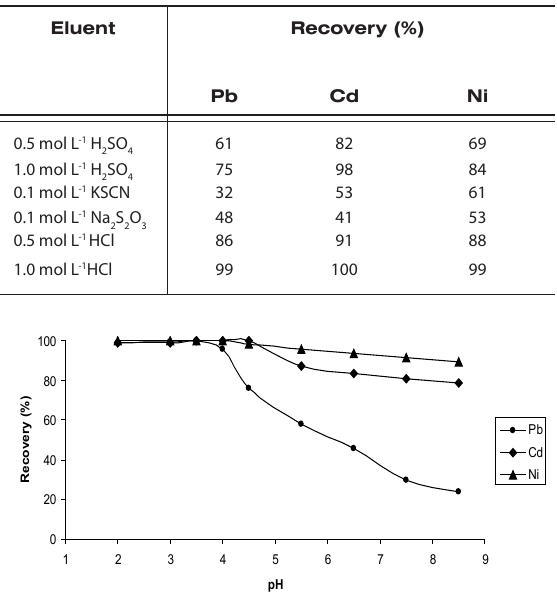
Table 1. Effect of type and concentration of eluent on the recovery of the investigated ions Eluent